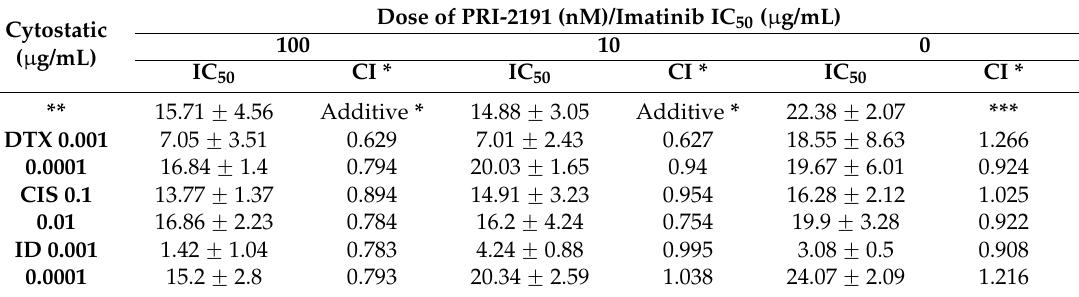
Table 1. The in vitro antiproliferative effect against human A549 cells of imatinib mesylate combined with PRI-2191 alone or applied with cisplatin (CIS), idarubicin (ID) or docetaxel (DTX).